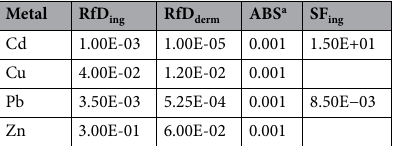
Table 2. The relative toxicity values used (based on the literature summary in Pecina et al. 36 ). a Dermal absorption